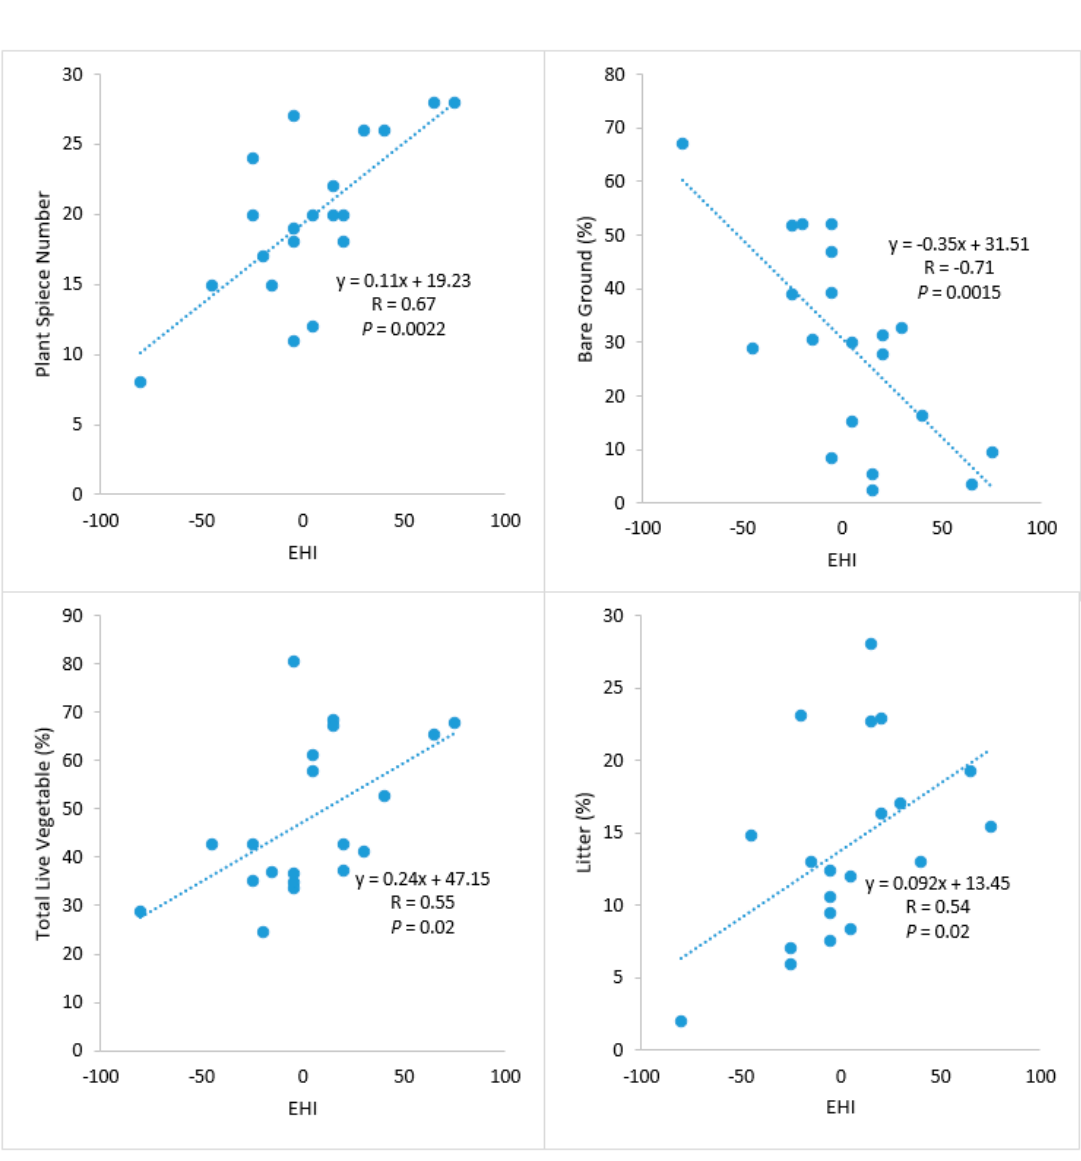
Figure 3. Linear regression for SG between EHI and QMs species richness, cover percentage of total live vegetation, bare ground and litter. Table 3. The correlation analysis between functional indexes (SSI, WCI, CDI and EFI) and quantifiable measurements (QM) in Humid Magellan Steppe (HMS) and Subandean Grasslands (SG). Species